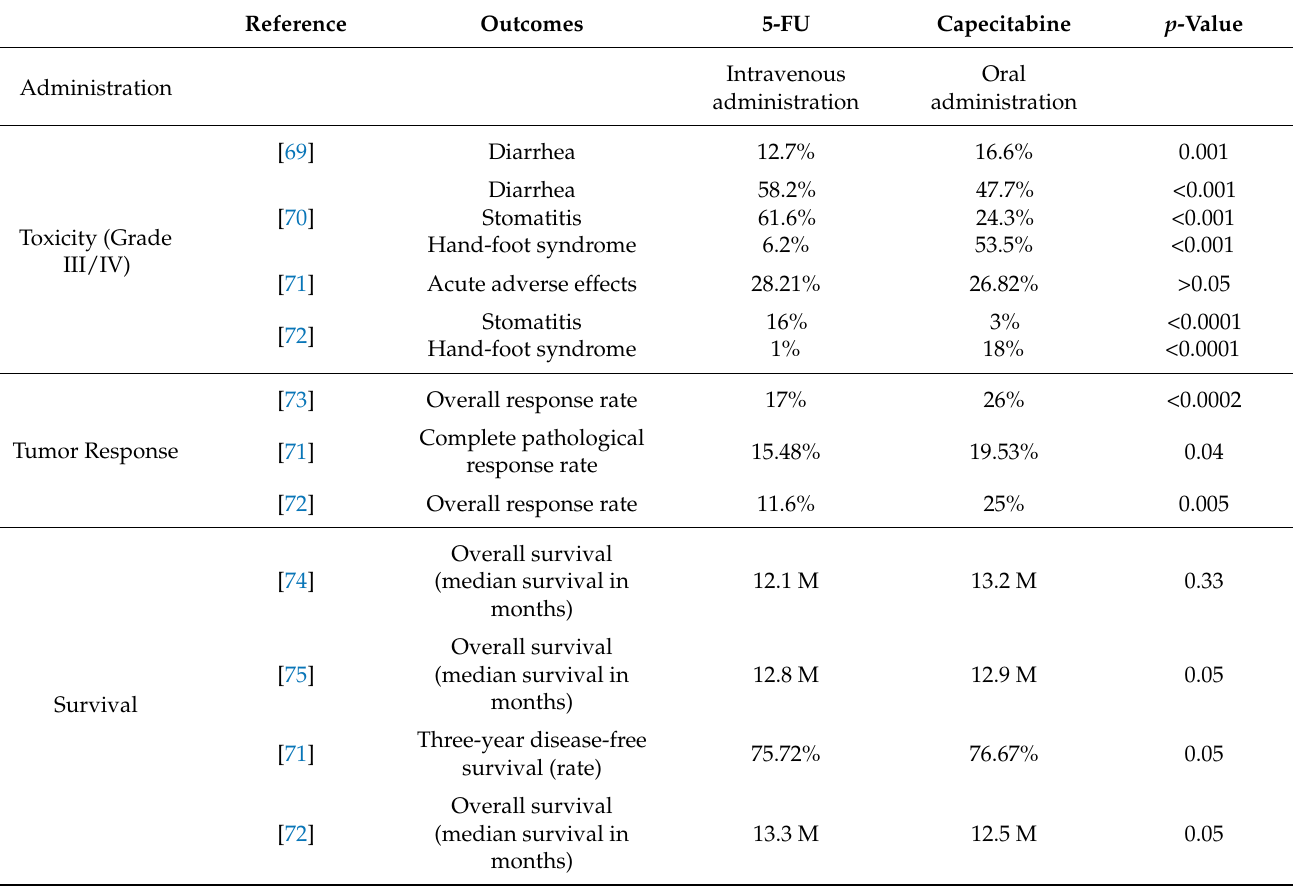
Table 2. Comparison of 5-FU- and capecitabine-based chemotherapeutic